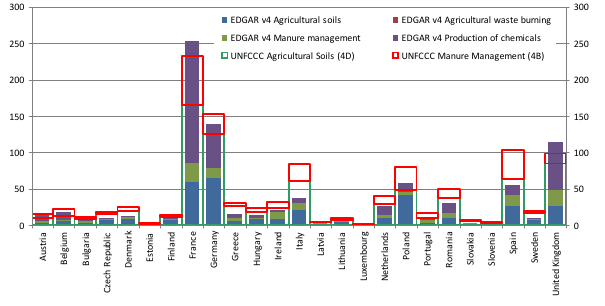
Fig. 4. Relative contributions of N 2 O emissions (in Gg N 2 O) from agricultural sources soils and manure management in the EU27 countries (not displaying Cyprus and Malta) according to the EDGAR v4 inventory (EDGAR, 2009) and compared to major agricultural sources as reported to UNFCC (Agricultural Soils, NRF 4D; Manure Management, NRF 4B) (UNFCCC, 2009)